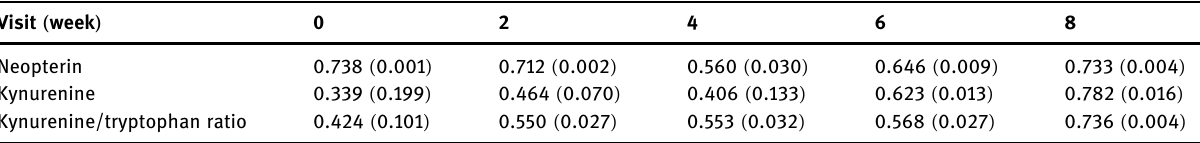
Table 2: Correlation ( Spearman ’ s rank correlation coe ffi cient ) between age and serum neopterin and kynurenine concentrations, and kynurenine/tryptophan ratio before and during the course of the treatment ( p values in parentheses )